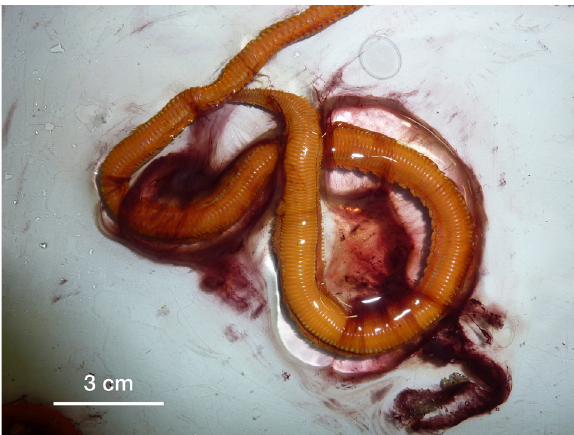
Fig. 1. – Halla parthenopeia (40 cm long) a few minutes after me- chanical stimulation, surrounded by abundant transparent mucus and, further outward, by purple mucus.